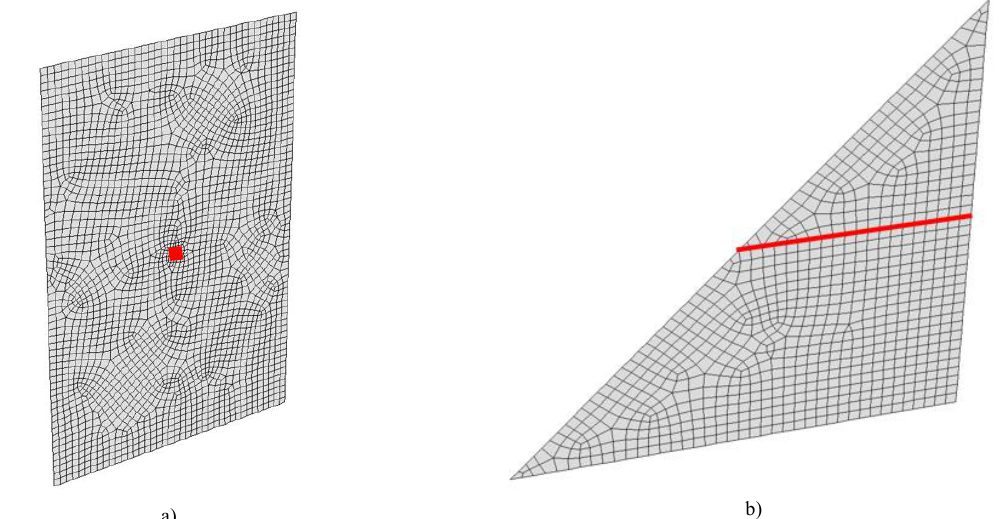
Fig. 3 Typical meshes for: a) concentrated load in a rectangular DGU and b) linear load in a triangular DGU. The regions where the forces are applied have been highlighted in red.